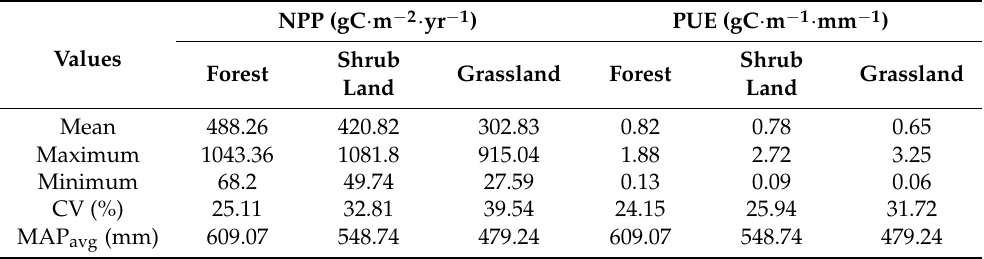
Table 1. The spatial mean, maximum, minimum, coefficient of variation(CV) of the forest, shrub land, grassland NPP and PUE, and the spatial average MAP(MAP avg ) in their respective distribution areas.